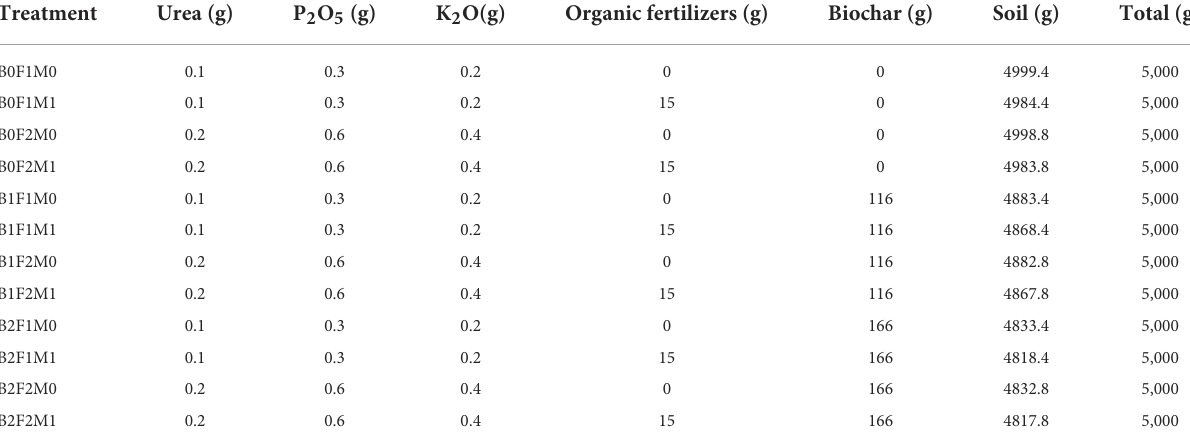
TABLE 2 Treatment combinations of biochar, inorganic fertilizer, and organic fertilizer in each pot.